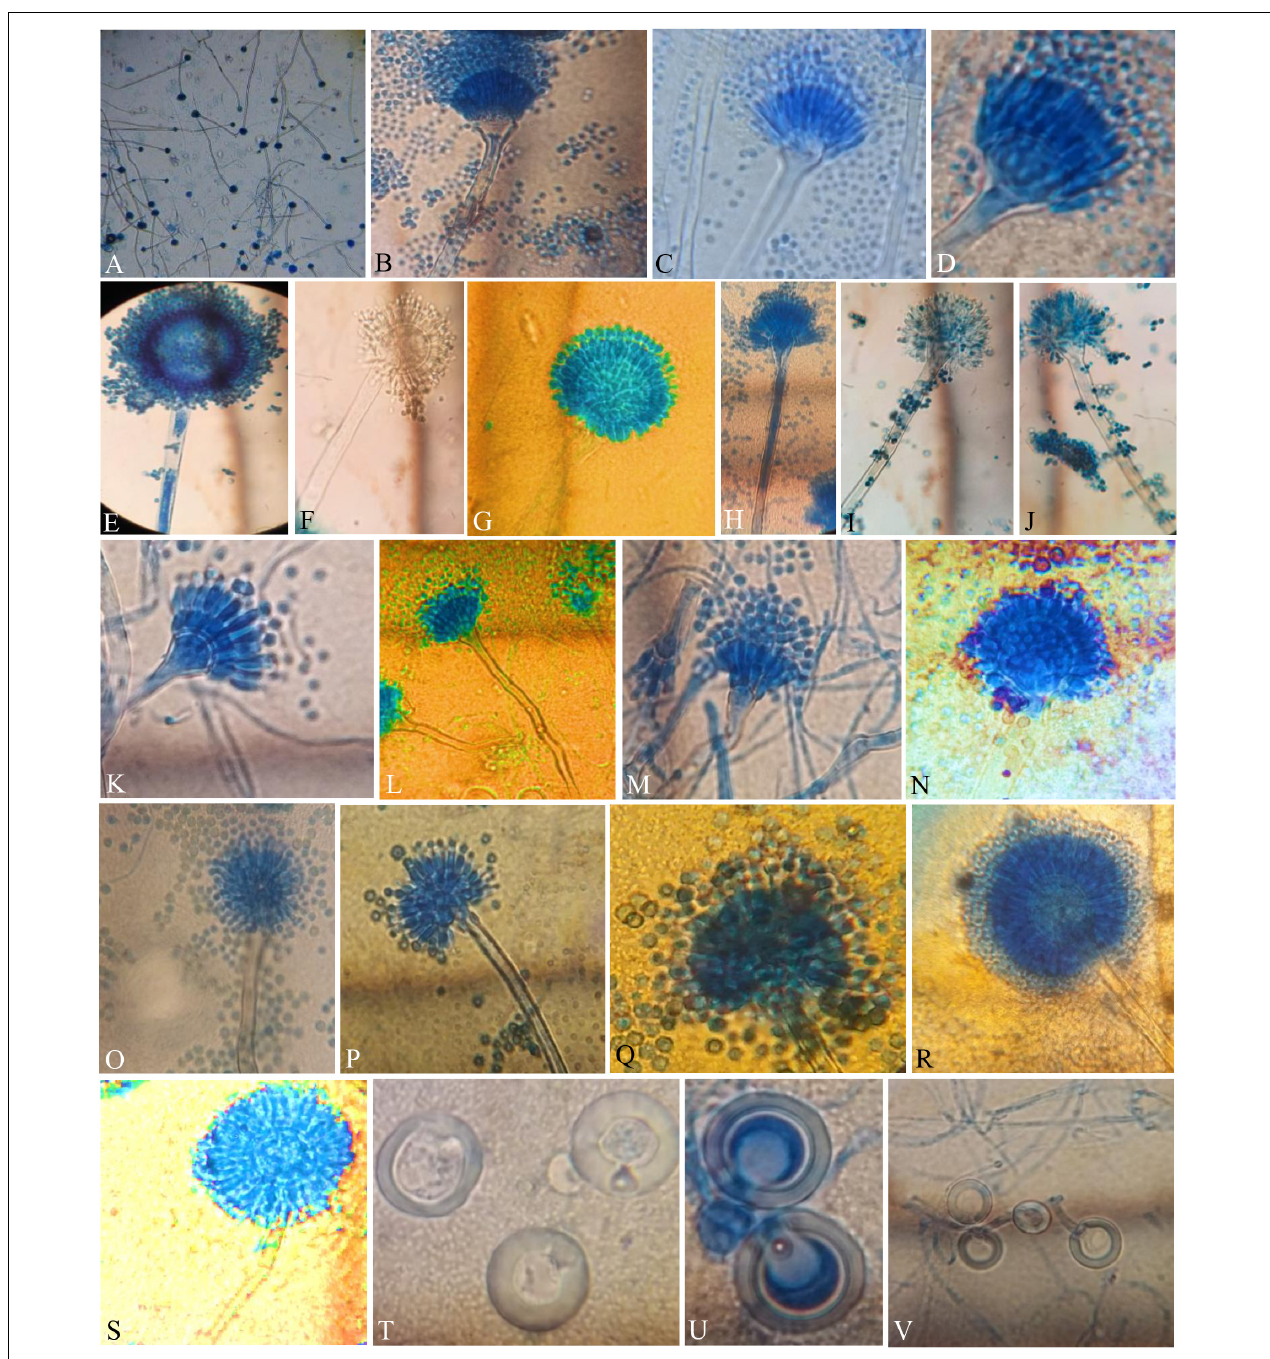
FIGURE 3 | Compound Light Microscope (CLM) images of the hyphae, conidiophores, and Hülle cells, (A,B) hyphae and elongated conidiophores of A. aureoterreus ; (C,D) enlarged conidiophores of A. terreus ; (E,F) stained and unstained conidiophores of A. flavus ; (G) enlarged conidial head of A. tamarii ; (H–J) conidiophores with bottle-shaped vesicles, uniseriate sterigmata, and conidia of A. fumigatus ; (K) enlarged conidiophores of A. nidulans ; (L) conidiophores of E. quadrilineata ; (M) conidiophores of A. latus ; (N,O) A. awamori conidiophores; (P,Q) A. sydowii conidiophores; (R,S) Aspergillus species conidiophores, and (T–V) A. nidulans , E. quadrilineata , and A. latus Hülle cells, respectively.